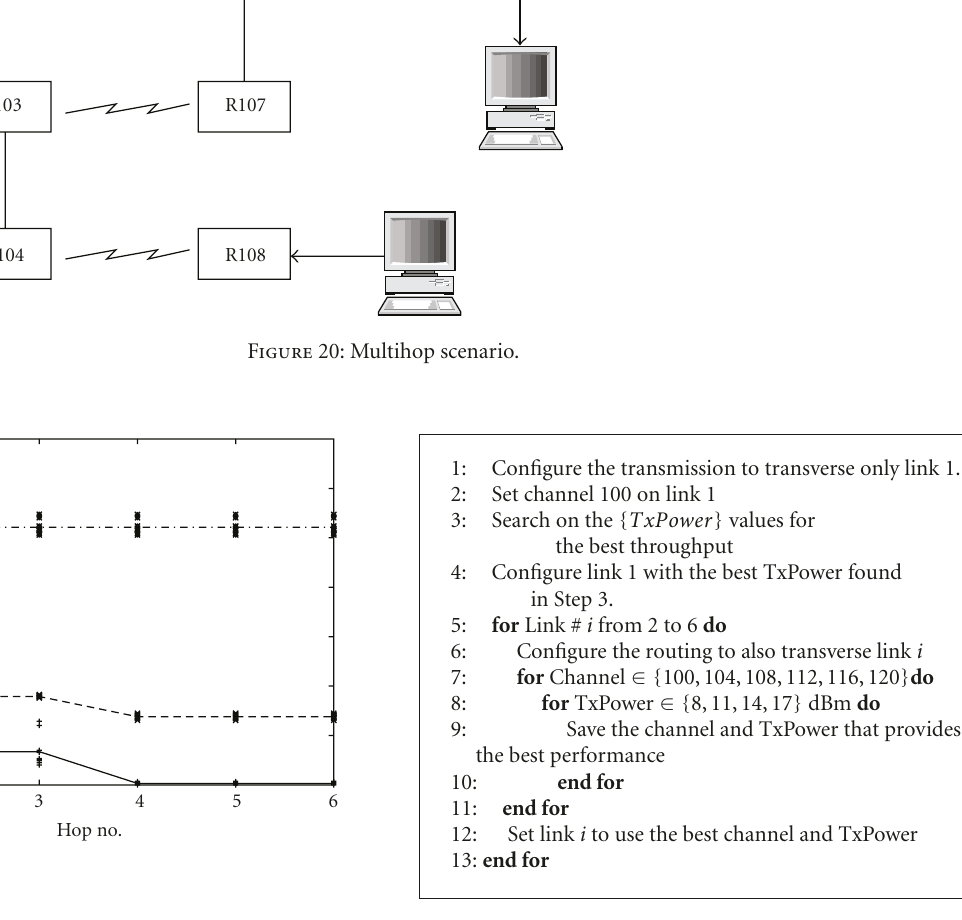
Algorithm 1: Heuristic for the configuration of the multihop